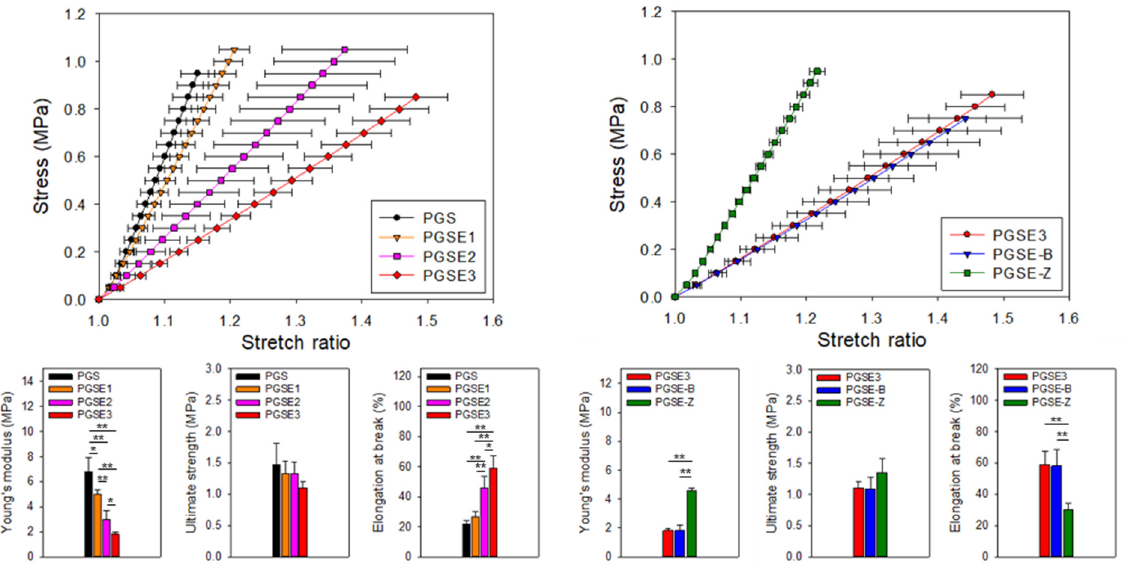
Figure 5. Average stress–stretch curves and mechanical properties of PGS, PGSE1, PGSE2, PGSE3, PGSE-B, and PGSE-Z (* means p < 0.05 and ** means p < 0.001).